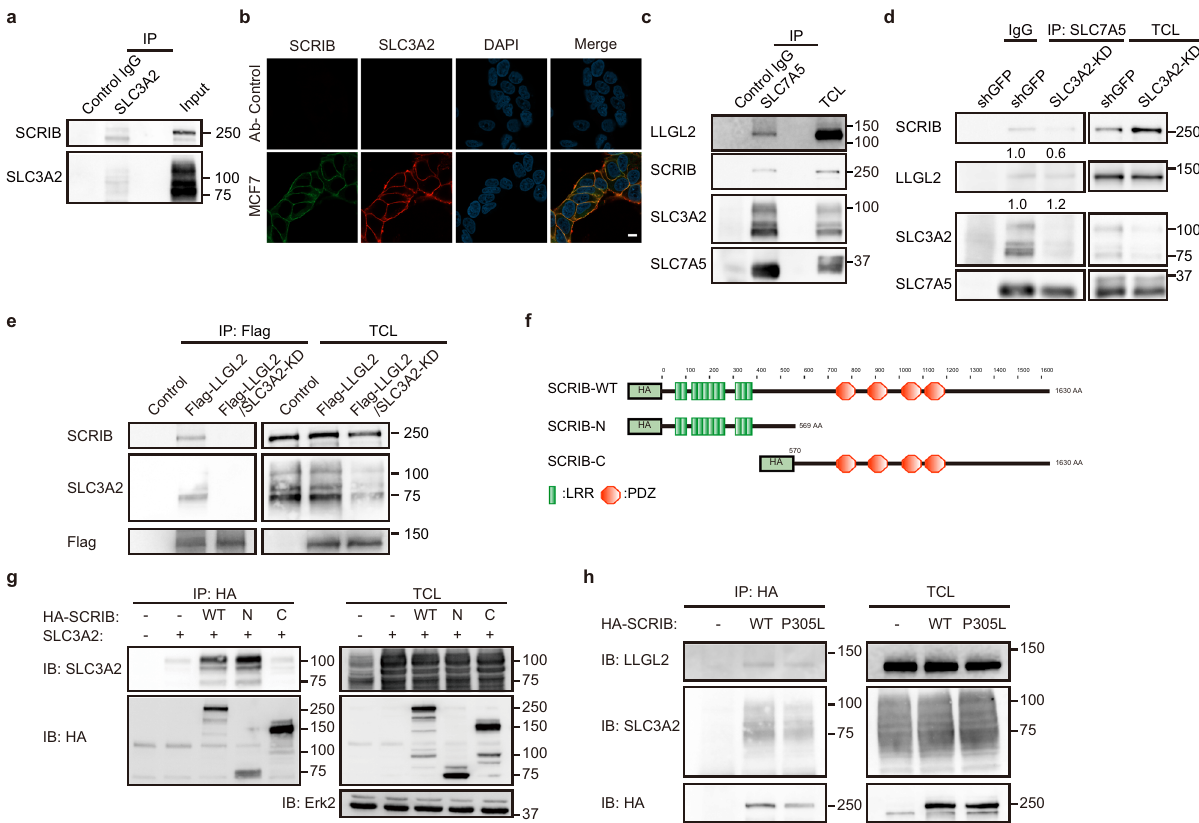
Fig. 2 SCRIB targets SLC3A2 in ER + breast cancer cells. a Detection of endogenous SCRIB-SLC3A2 interaction in MCF-7 cells. b Co-localization of SCRIB and SLC3A2 in MCF-7 cells. Scale bar, 10 µ m. c Immunoprecipitants using the anti-SLC7A5 antibody in MCF-7 cells. d Immunoprecipitation of SLC7A5 in SLC3A2-KD cells. e Immunoprecipitation of Flag-LLGL2 using anti-Flag antibody in SLC3A2-KD MCF-7 cells. f Cartoon representation of wild-type SCRIB and SCRIB mutants. g Immunoprecipitation of SCRIB in HEK293T transfected with indicated vectors. h Immunoprecipitation of wild-type and mutant SCRIB in MCF-7